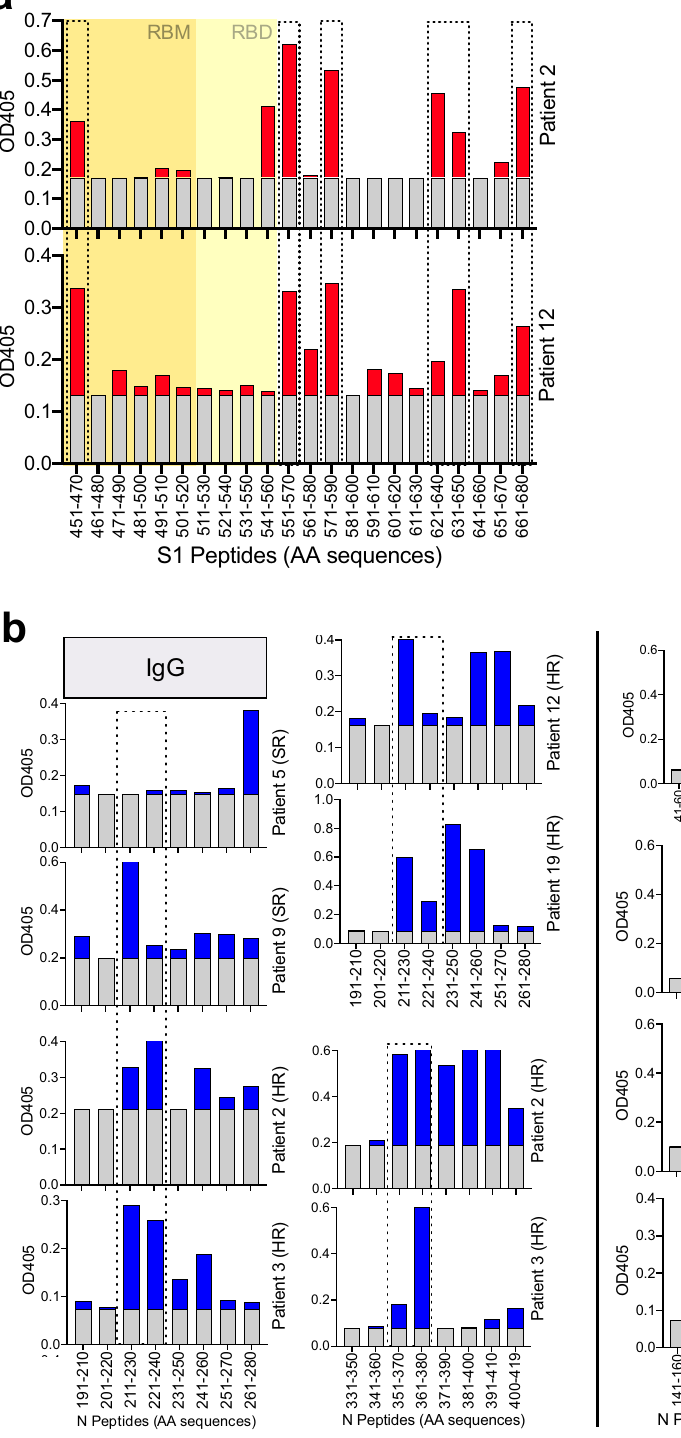
Fig. 7 Detailed characterization of the B cell epitope landscape in COVID-19 patients. a Plasma samples from two patients with known SARS-CoV reactivity were analyzed for IgG responses against individual 20mer peptides of the S1 protein covering the RBD (highlighted in yellow), the RBM within the RBD (highlighted in orange), and the region C-terminally adjacent to the RBD. b Plasma samples from six patients with known SARS-CoV reactivity were analyzed for IgG and IgA responses against individual 20mer peptides of the N protein. Values represent ODs in an ELISA assay and shared epitopes are marked using dotted